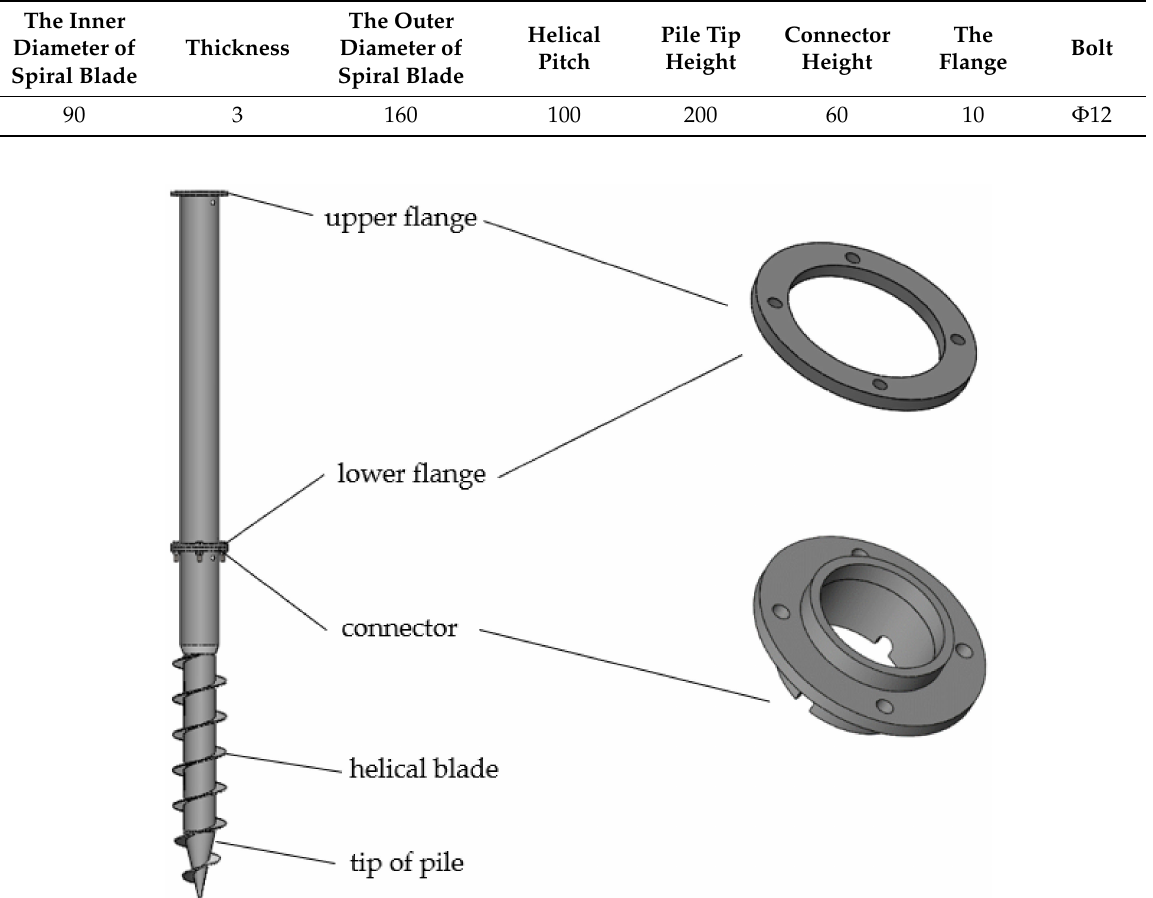
Figure 1. Structural drawing of spliced helical